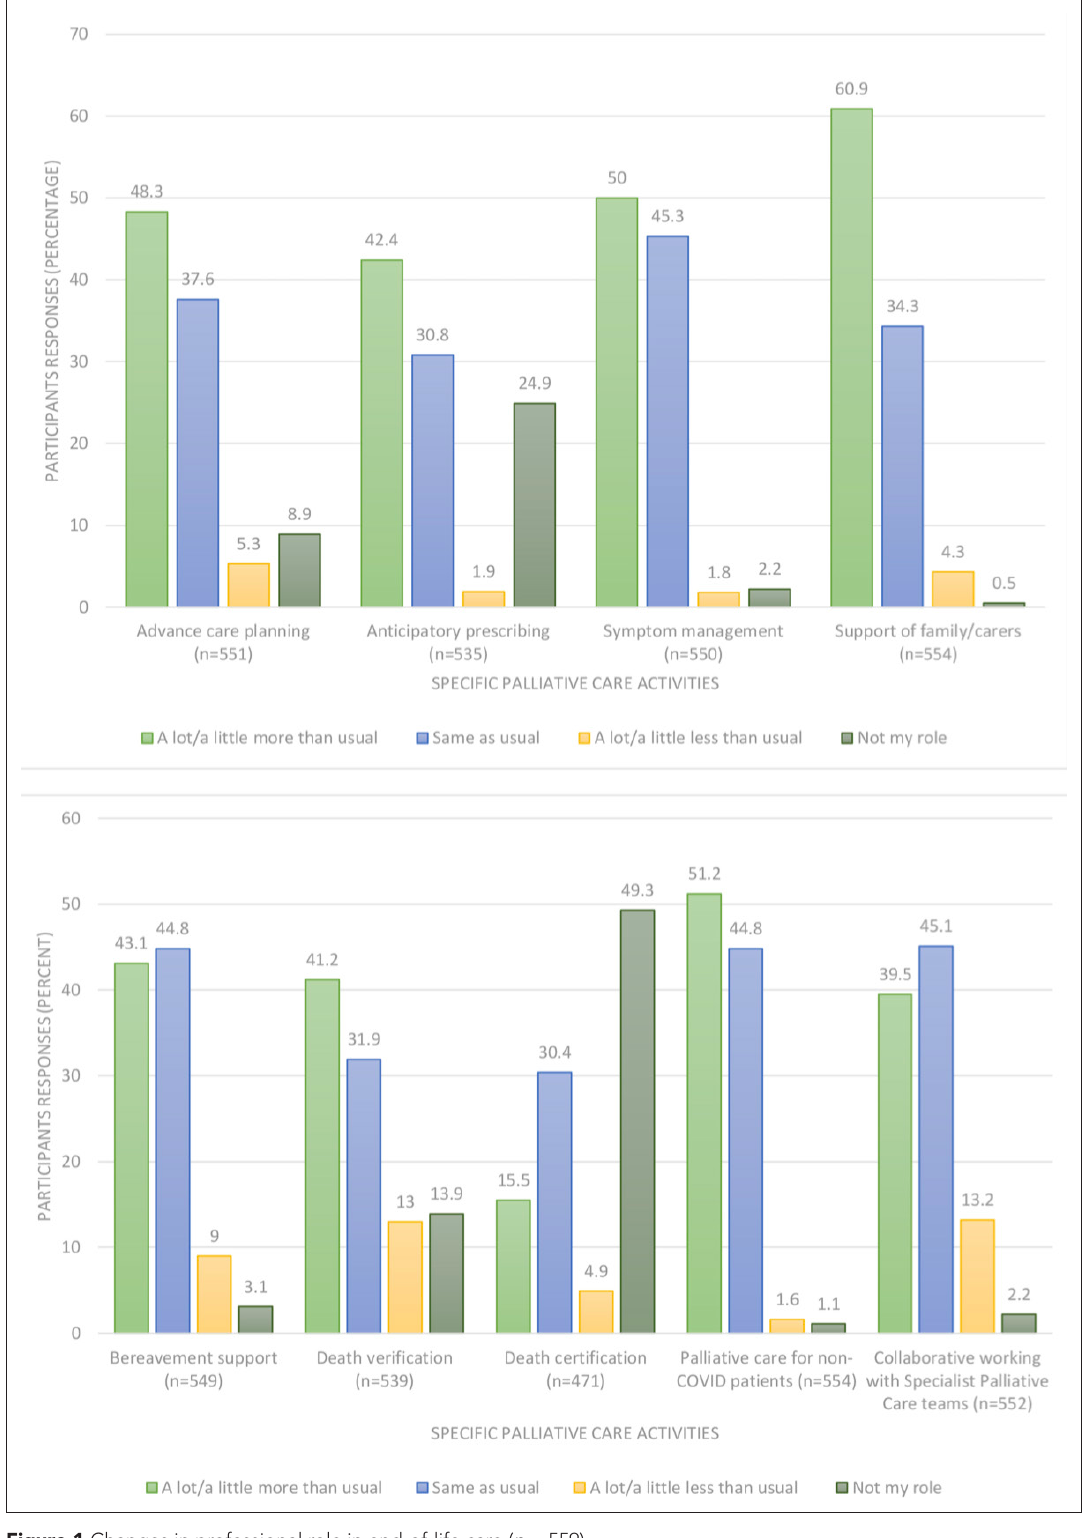
Figure 1 Changes in professional role in end- of- life care ( n =